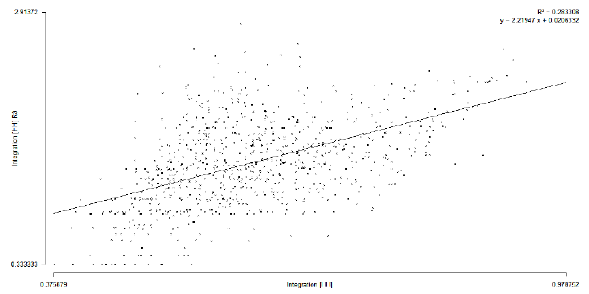
Figure 4. Scatter plots of streets and alleys in Qianmen area during the Qianlong dynasty